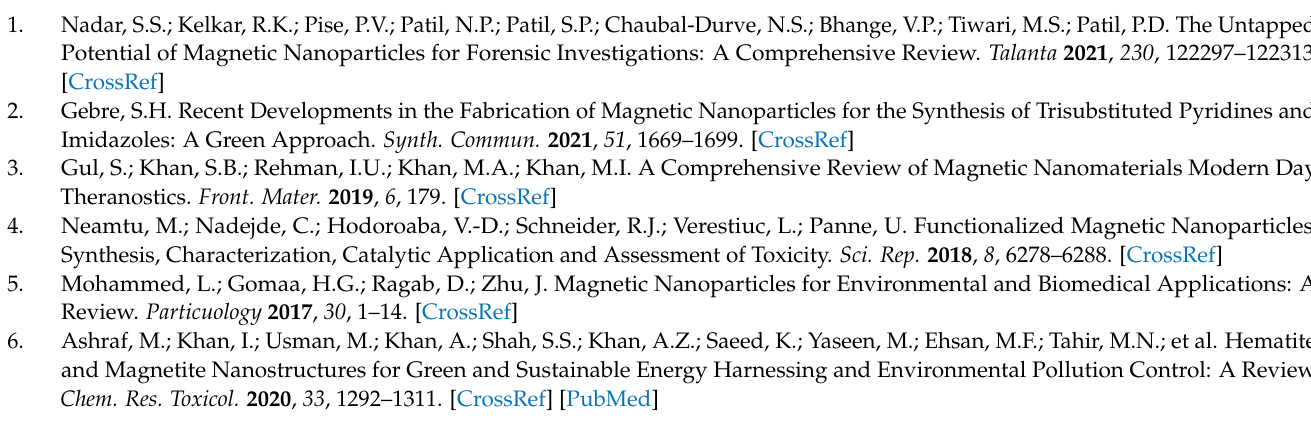
the related species. Figure S2: (A) TEM image of nano-Fe 3 O 4 at 400,000 × magnification. (B) The corresponding particle size distribution graphs (N = 60). Figure S3: (A) Cyclic voltammograms of bare SPCE in solution I for 10 cycles. Cyclic voltammograms of SPCE/nano-Fe 3 O 4 in a mixture solution of (B) 1.0 mM glyphosate and 0.1 M KCl (C) 1.0 mM K 3 Fe(CN) 6 and 0.1 M KCl solution